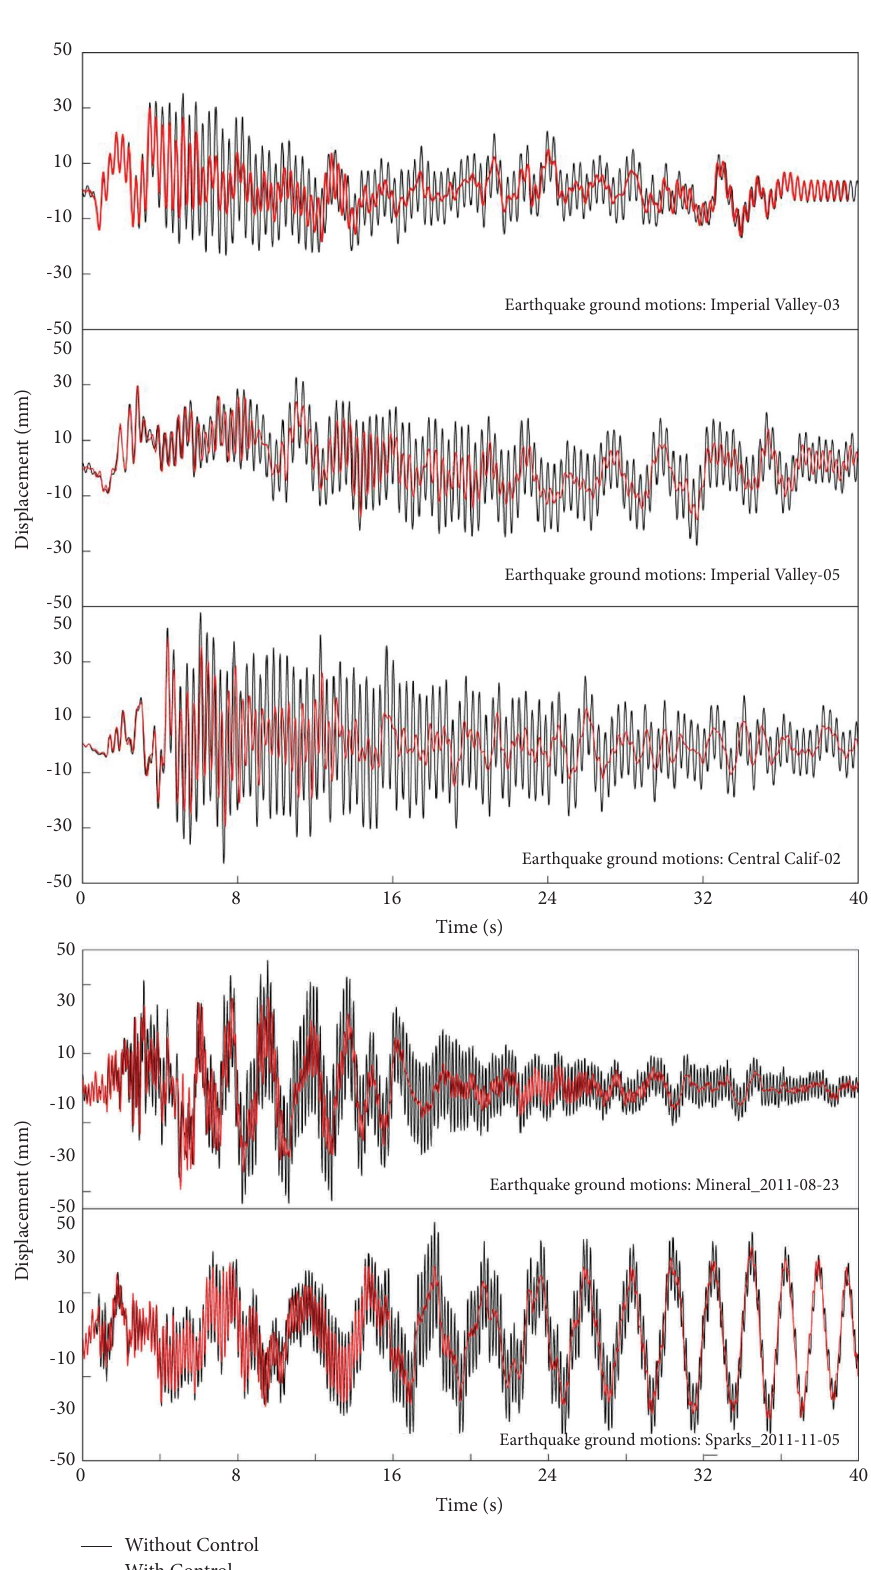
Figure 9: Time-history response of frame structure under diferent earthquake excitations: (a) Imperial Valley-03; (b) Imperial Valley-05; (c) Central Calif-02; (d) Mineral_2011-08-23; (e)